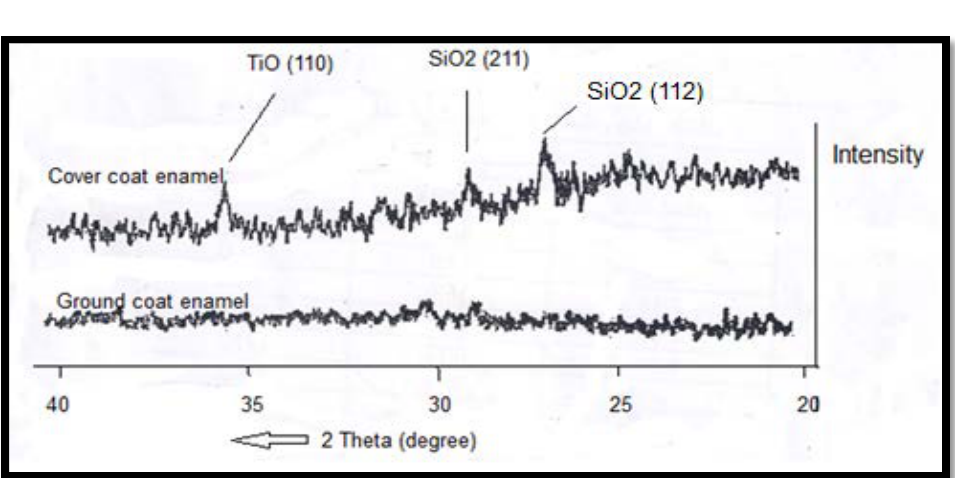
Fig. 2: X-ray diffraction spectrum for ground coat and cover coat enamel.